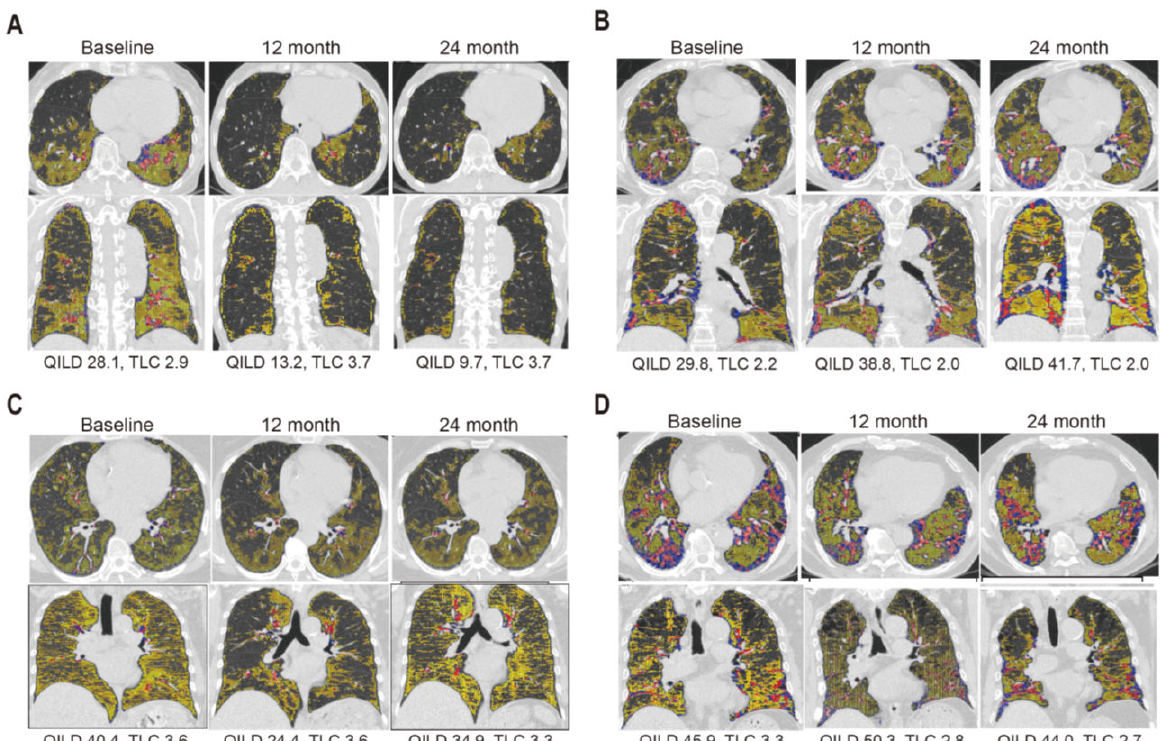
Figure 6. Four cases representing dynamic change of the severity of RA-ILD during 2 years (cohort 2). QILD scores were calculated for each patient who had 3 HRCT scans with 1 year interval without obvious acute exacerbation: ( A ) Improved case (Patient 9), ( B ) Worsened (Patient 5), ( C ) Convex (Patient 12), and ( D ) Concaved changed (Patient 3). Upper row: transverse view; Lower row: coronal view; QLF = sum of red and blue dot, QGG = yellow dot. Four distinct patterns of change in 3 longitudinally-obtained QILD scores (cohort 2, n = 24). ( A ) Whole lung QILD